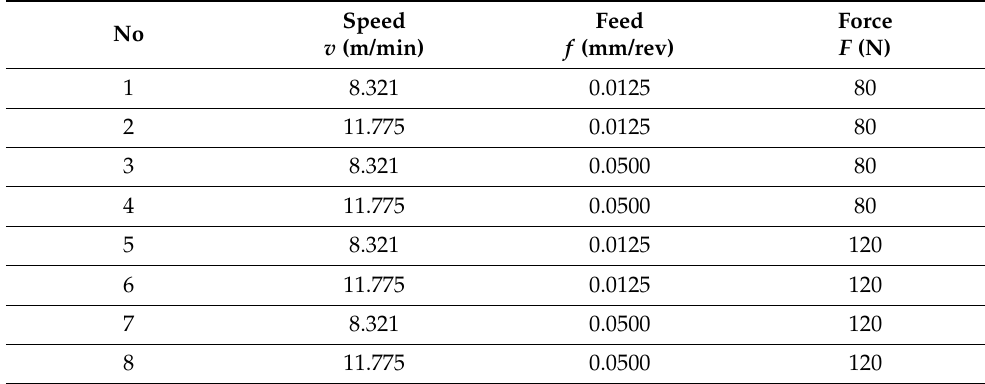
Table 2. Burnishing technological experimental parameters.